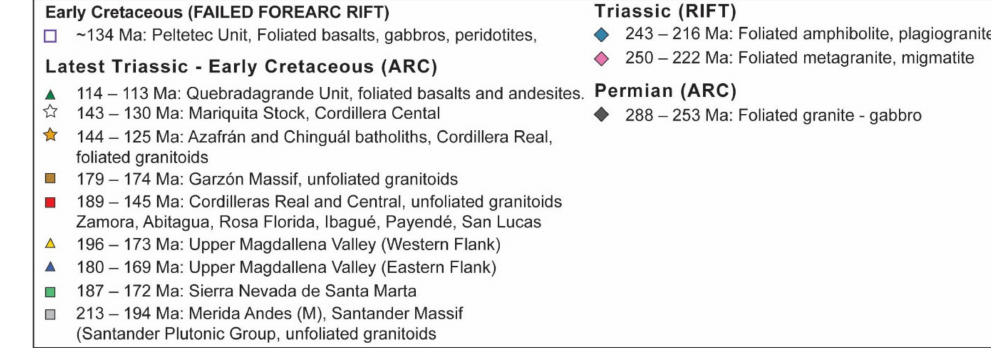
Figure 3. A comparison of crystallisation age (mainly zircon 238 U- 206 Pb concordia ages) and latitude, showing the main arc and rift stages within northwestern South America. GP: Guajira Peninsula, SNSM: Sierra Nevada de Santa Marta, TI: Toas Island. Citations for dates are listed in the caption for Figure